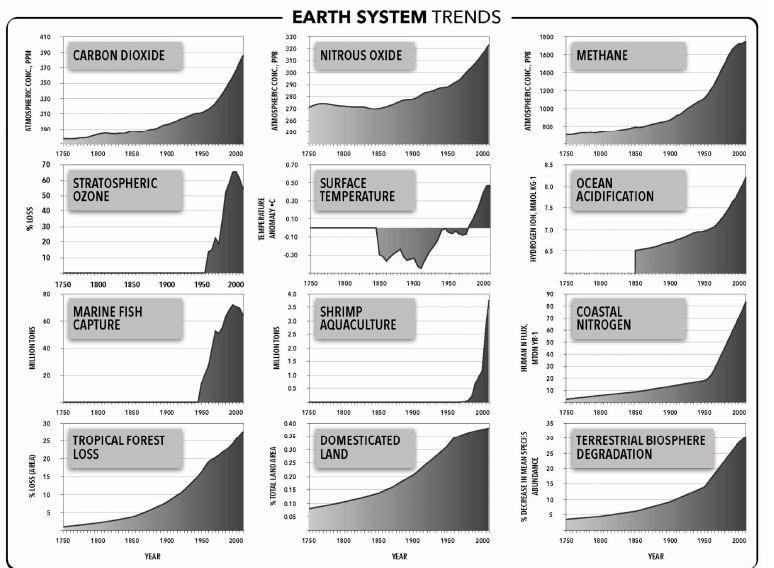
Figure 1. Earth System trends, adapted from the data from Steffen et al. (2015a). Note the general steep acceleration after 1950.